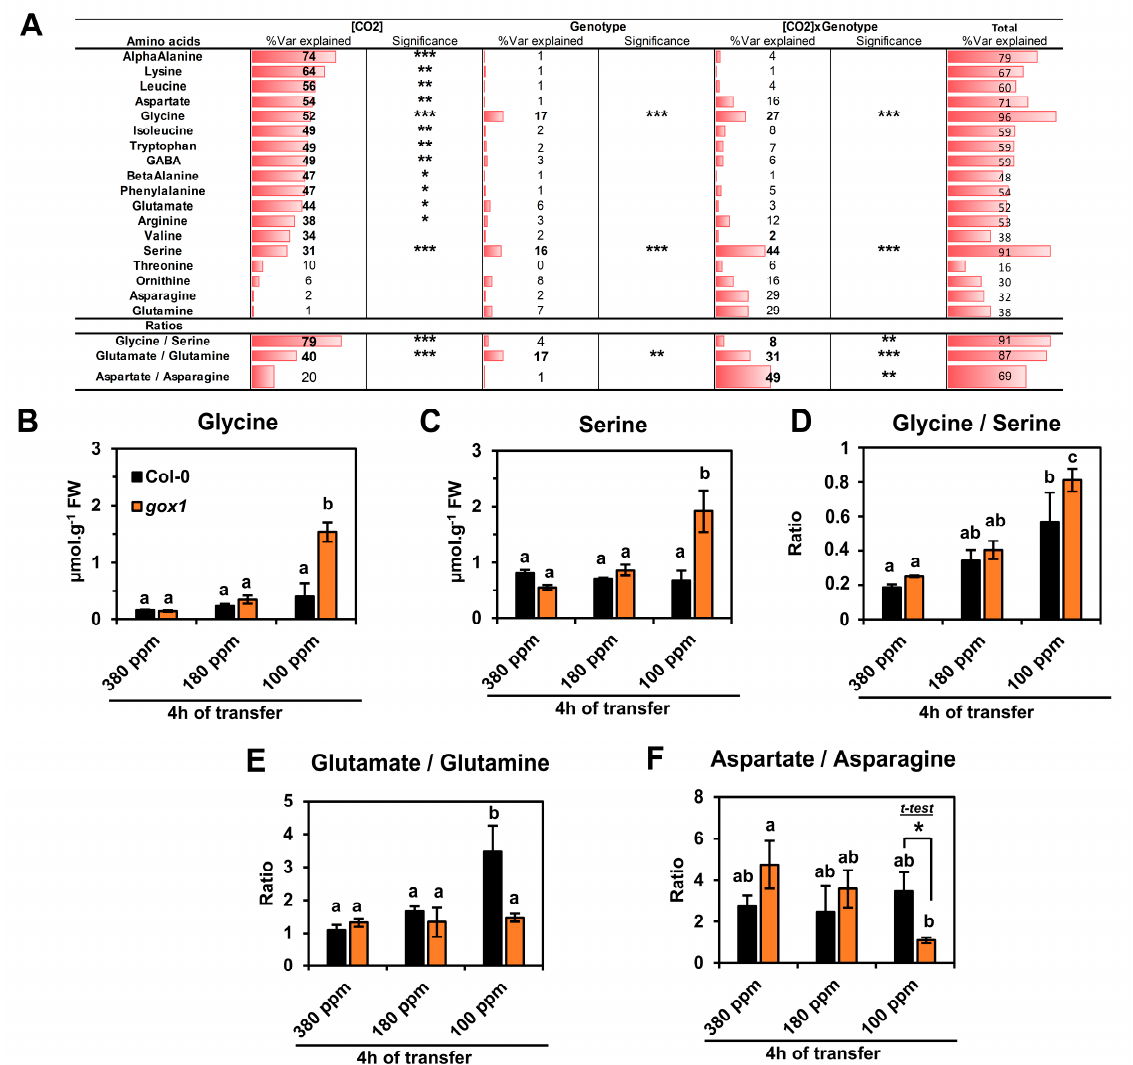
Figure 2. Statistical analyses of amino acid variations associated with short-term exposure to low CO 2 (180 and 100 ppm for 4 h) in wild-type and gox1 Arabidopsis thaliana Col-0. ( A ) Two-way ANOVA analysis of amino acid contents from rosette leaves of Col-0 and gox1 plants after 4 h of exposure to an atmosphere with 380, 180 or 100 ppm CO 2 . ( B ) Glycine and ( C ) Serine contents, ( D ) Glycine/Serine, ( E ) Glutamate/Glutamine and ( F ) Aspartate/Asparagine ratios. Results are expressed as the mean ± standard deviation of three independent biological replicates. Different letters indicate groups of mean values that are significantly different between the different conditions (two-way ANOVA test followed by a post-hoc Tukey HSD test, p -value < 0.05). *** p -value < 0.001; ** p -value < 0.01; * p -value < 0.05. Var = Variance.